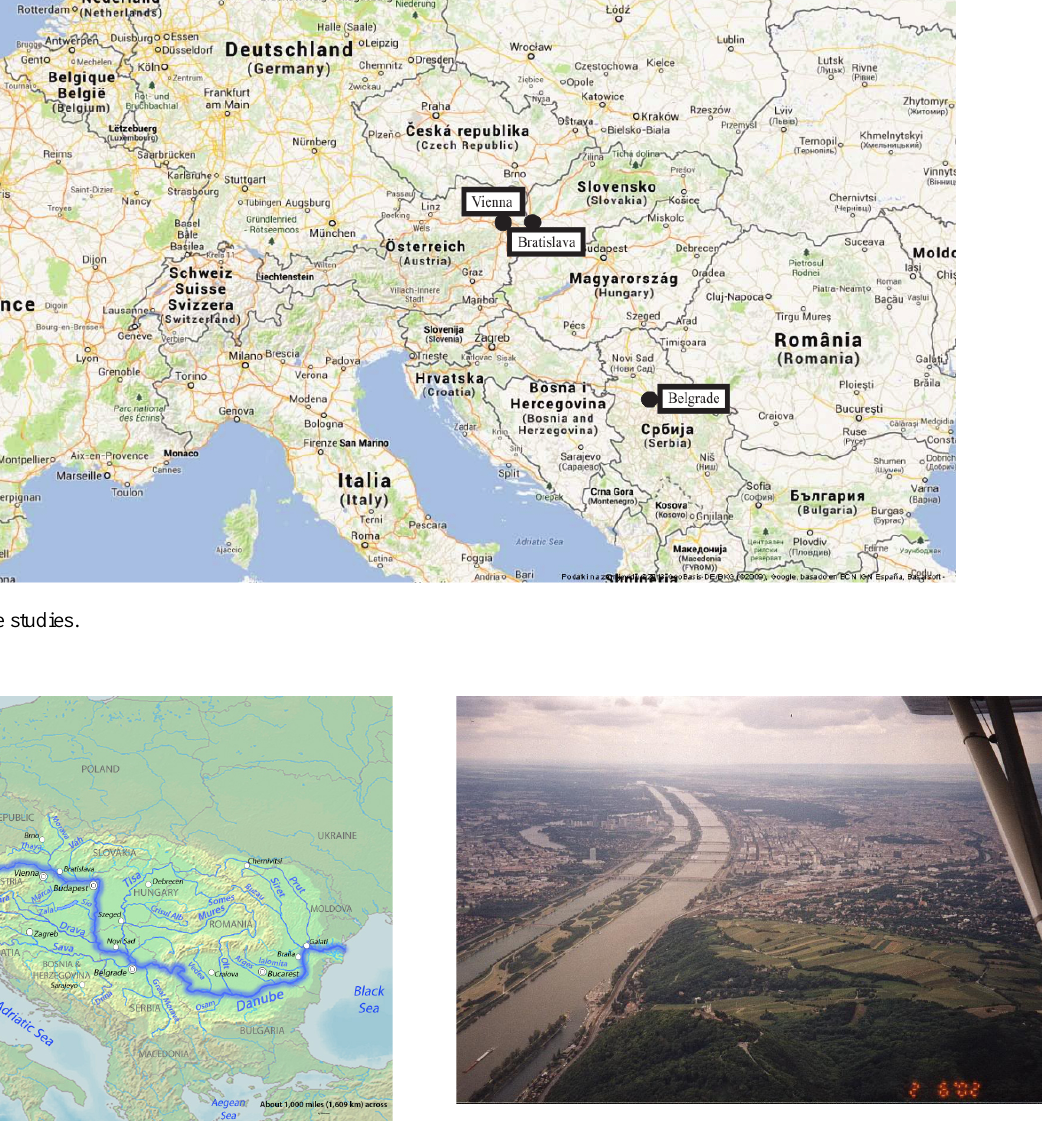
Fig. 3. The Danube Island (http://www.viennaresidence.com/files/